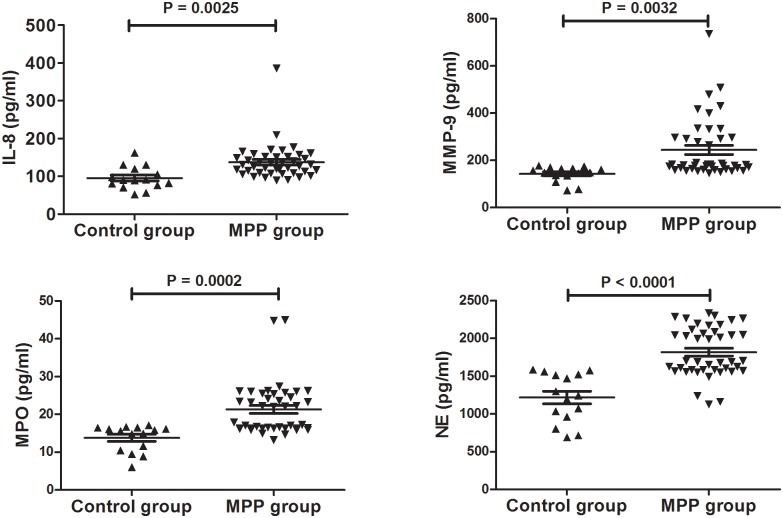
Comparison of IL-8, MPO, MMP-9, and NE levels in BALF between Patients with MPP and Controls.The values in the graphs represent the mean ± SD. The P values were calculated using Student’s t test while Mann-Whitney U-test was used for comparison of MMP-9 between MPP and control groups. MPP: Mycoplasma pneumoniae pneumonia; IL: interleukin-8; MPO: myeloperoxidase; MMP-9: matrix metalloproteinase 9; NE: neutrophil elastase.